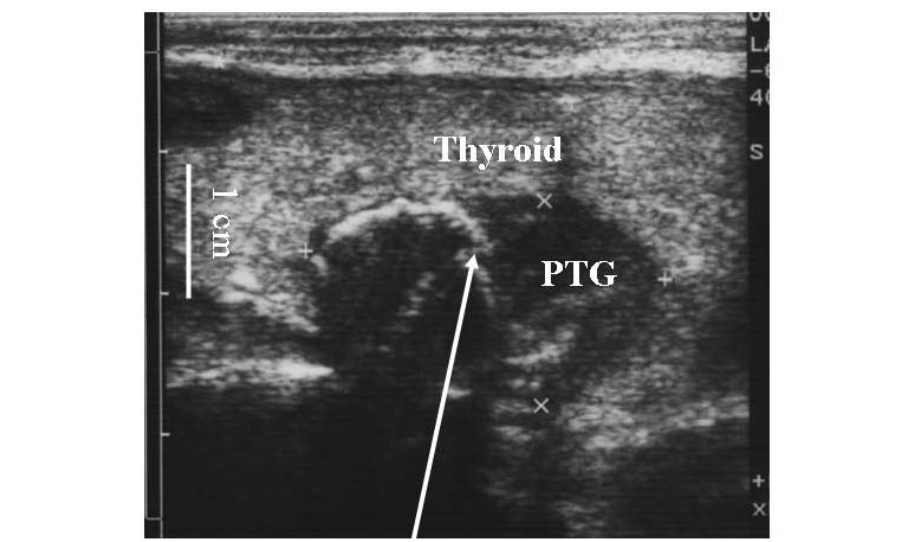
FIGURE 10. PTG with calcifications in 40-year-old woman, on dialysis treatment 12 years, PTH 1775.9 pg/ml (longitudinal section, linear probe 10